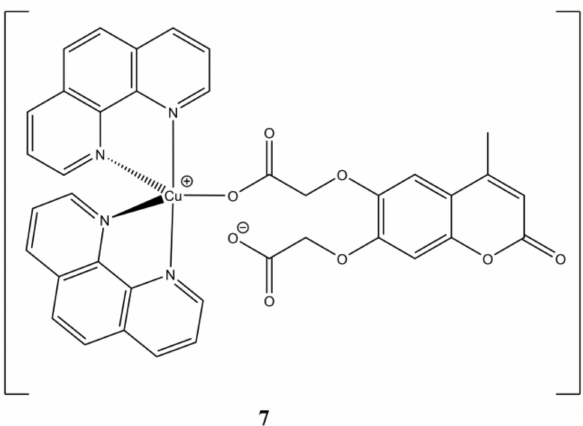
Figure 7. Structures of the [Cu(phen) 2 (4-Mecdoa)] complex. Kellet et al. used ftalic acids to prepare the mixed mononuclear [Cu(phen) 2 (PHTn)] (n = 1,2; Figure 8a,b) and binuclear [Cu 2 (phen) 4 ( µ -PHT3)](PHT3) (Figure 8c) complexes [33].